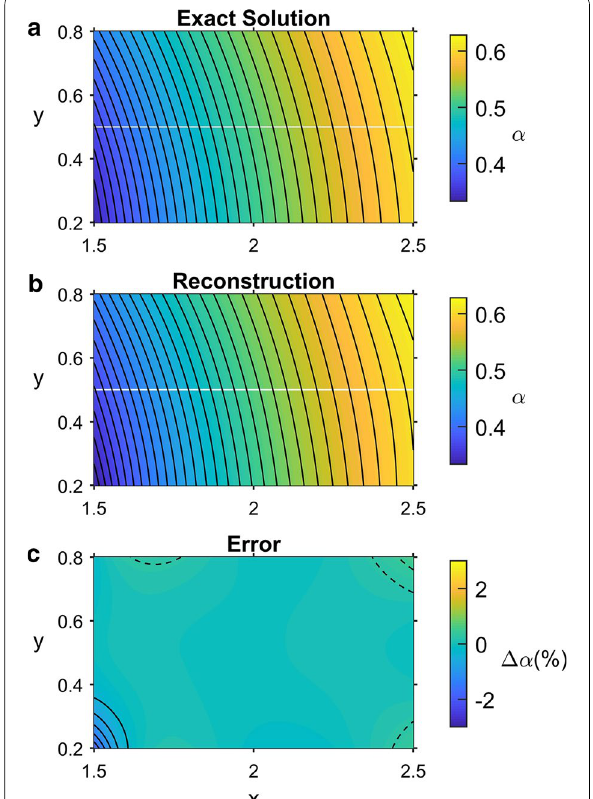
Fig. 1 a Analytic results for magnetic field lines of F t in the x – y plane and pressure anisotropy α in color. b Reconstruction results in the same format. c Errors for vector potential in contour lines and α in color. The solid and dashed curves represent positive and negative errors at 0.5%